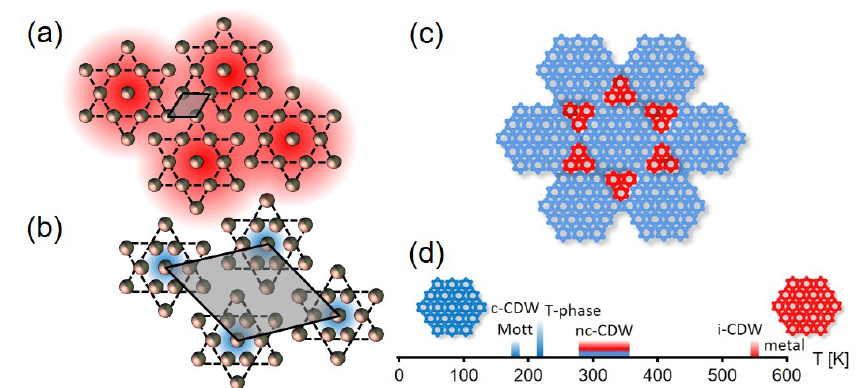
Figure 1. Local nuclear configuration in the Ta-plane of 1 T -TaS 2 in the metallic high- and insulating low-temperature phase (( a , b ), respectively); Grey shaded areas indicate the primitive 1 × 1 and √ √ 13 × 13 R 13.9 ◦ superstructure unit cells. Upon contraction of the individual stars, the charge density (indicated as blue and red shaded areas) localizes on the central atom of the polaron cluster. At elevated temperatures, periodic arrangements of insulating and metallic domains are formed as depicted in ( c ); which shows the corner-sharing hexagon model of the nc-phase proposed from X-ray diffraction data [11], while edge-sharing hexagons were reported from transmission electron microscopy studies [17,18]; ( d ) Schematic overview of the different equilibrium phases, being either dominated by insulating (blue) or conducting (red) domains. ( c -commensurate, T -triclinic, nc -nearly commensurate, i -incommensurate